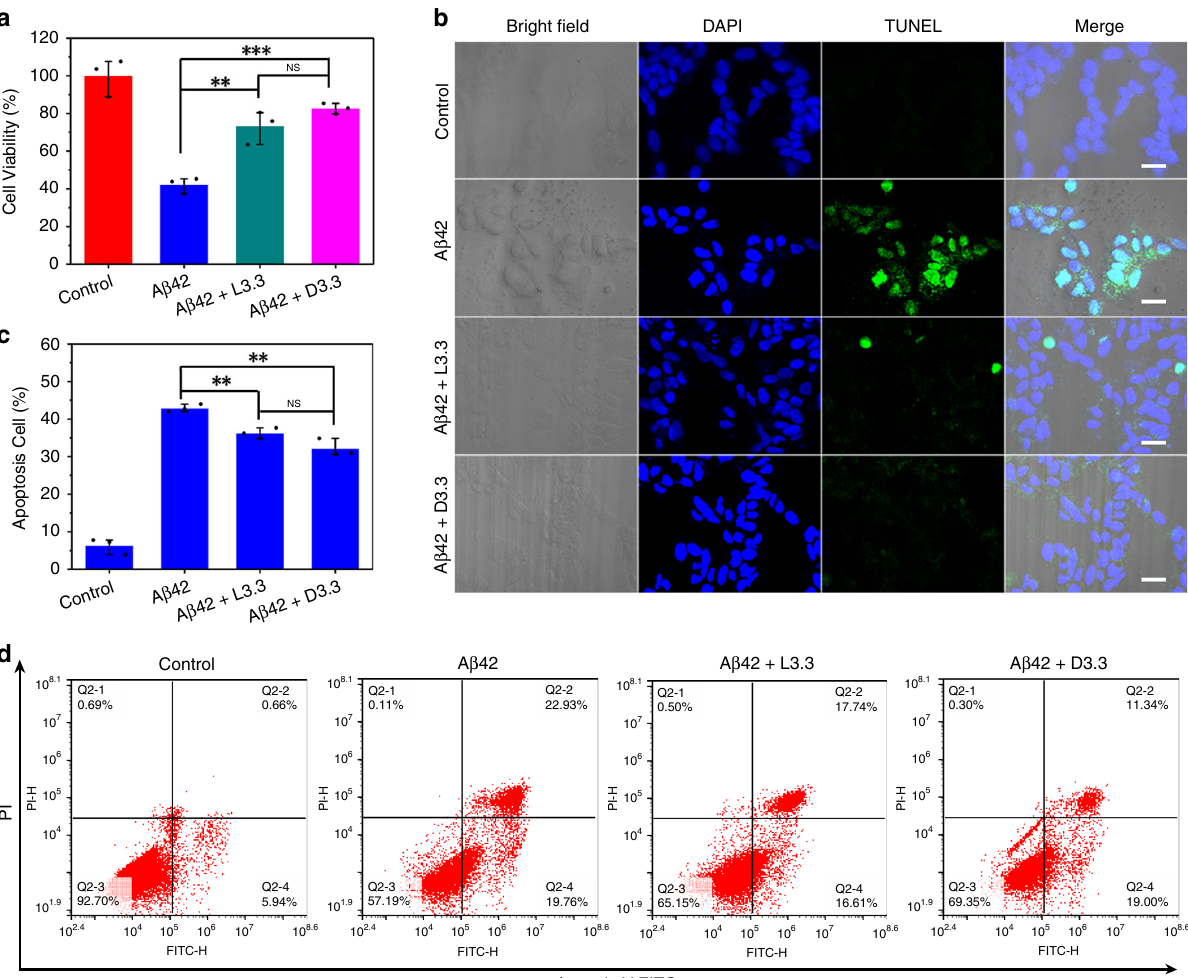
Fig. 3 Inhibition effect of L3.3 and D3.3 on A β 42-induced neuronal death. a Cell toxicity of A β 42 (40 μ M) in the absence and presence of L3.3 and D3.3 (110 nM). b Bright- fi eld and confocal fl uorescence images of SH-SY5Y cells treated with A β 42 (40 μ M) in the absence and presence of L3.3 and D3.3 (110 nM) for 48 h. Scale bars, 50 μ m. c Population of apoptosis cells summarized from fl ow cytometry analysis. d Flow cytogram representing apoptosis assay based on annexin V- fl uorescein isothiocyanate (Annexin V-FITC)/propidium iodide (PI) staining of SH-SY5Y cells after treatment with